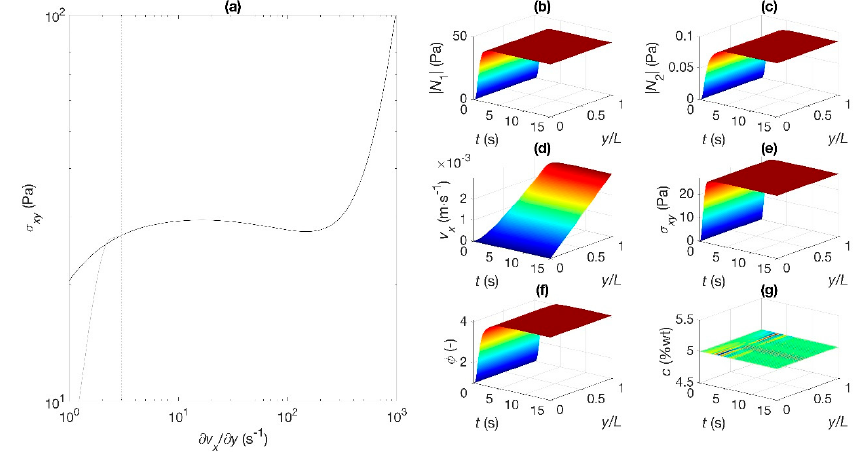
Figure 1. Steady state constitutive curves obtained under controlled shear rate starting from rest. Parameters used in the simulations are: 𝑐 (cid:2868) = 5 wt %, 𝜑 (cid:2998) = 847 m·s·kg − 1 , 𝜏 (cid:3097) = 1.06 s, 𝜂 (cid:2868) = 36.56 kg m − 1 s − 1 , 𝑘 (cid:2868) = 3.28 × 10 − 4 m s − 1 kg − 1 , 𝜆 = 0.136 s, 𝜗 = 0.0061 s, 𝜌 = 1000 kg m − 3 , 𝒟 = 1 × 10 − 5 m 2 s − 1 , 𝒟 (cid:4593)